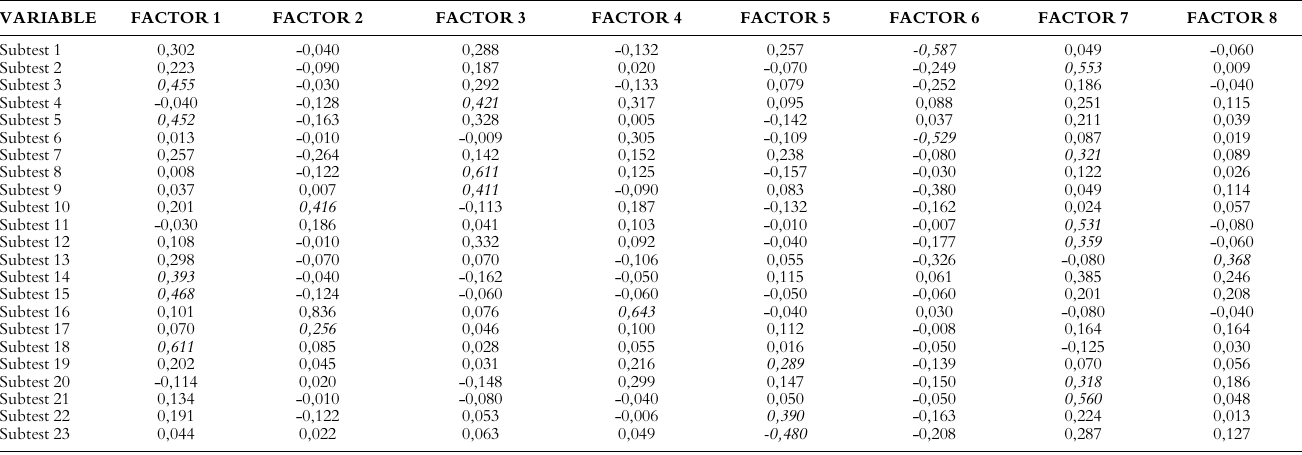
TABLE 3 ROTATED FACTORMATRIXOF THELEARNING STYLESPREFERENCEQUESTIONNAIRE (DIRECTOBLIMIN